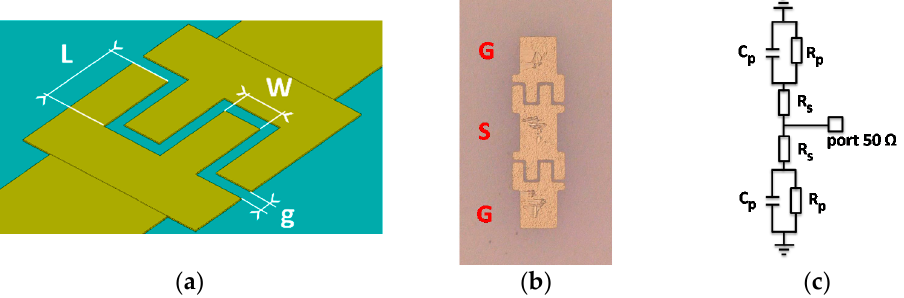
Figure 1. Topology of a typical metallic inter-digitated capacitor (IDC) structure on top of the ferroelectric ( a ), optical microscopy image of one of the fabricated device ( b ) and its equivalent electric scheme ( c ).